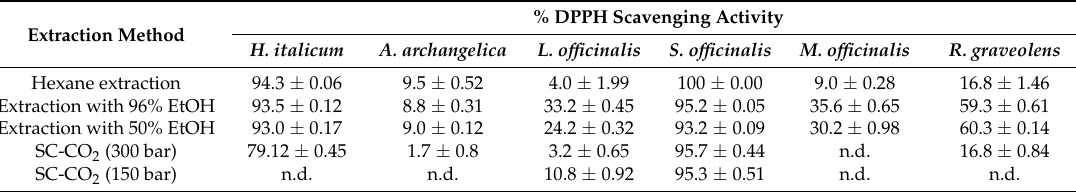
Table 3. Antiradical activity of the plant extracts (250 µ g/mL) as % 2,2-diphenyl-1-picrylhydrazyl radical (DPPH) scavenging